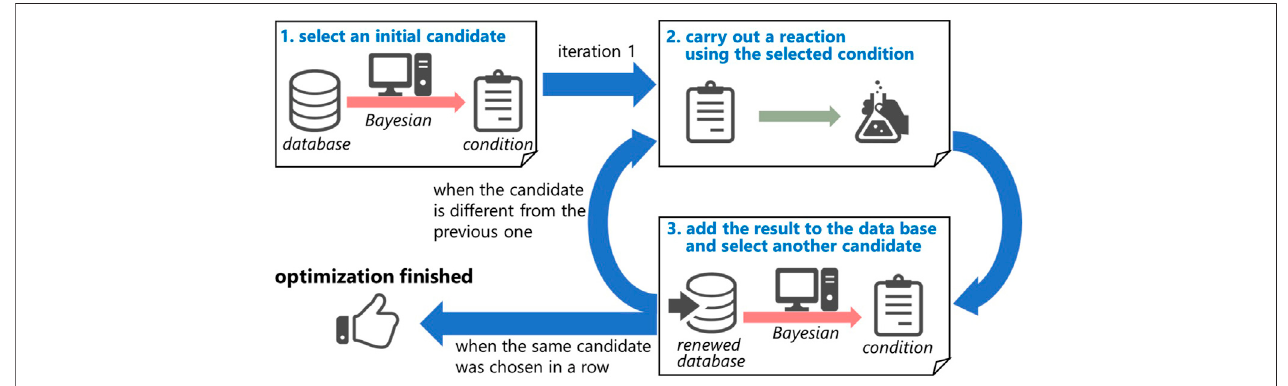
FIGURE 3 | Schematic of the bayesian optimization